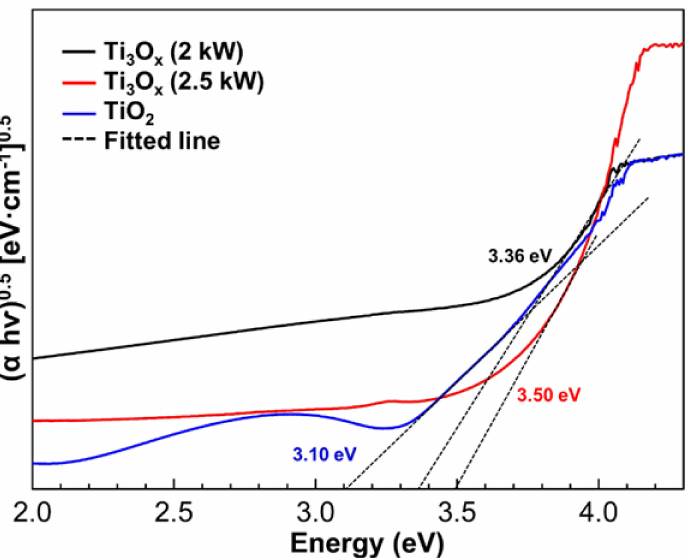
Figure 6. Indirect energy band gap value of the Ti 3 O x thin film deposited at 2 and 2.5 kW and TiO 2 thin film as